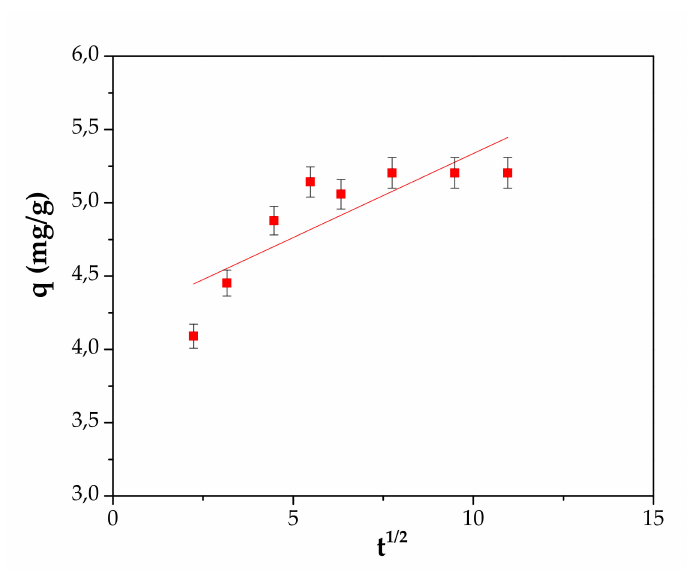
Figure 13. Intraparticle difussion model. Table 4. Kinetic parameters of Cd 2 + adsorption onto the FA / H 2 SO 4 sample.